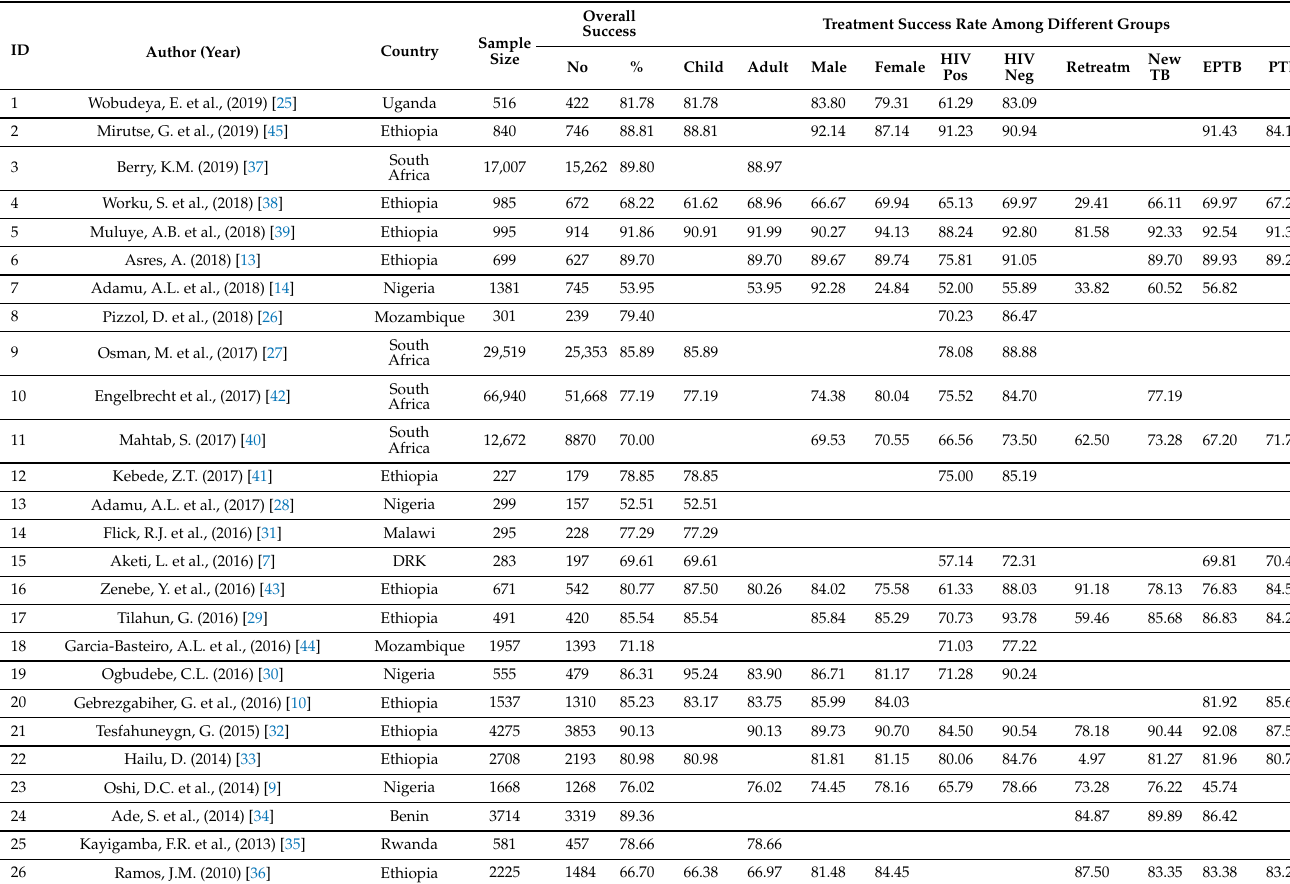
Table 1. Characteristics of included studies for systematic review and